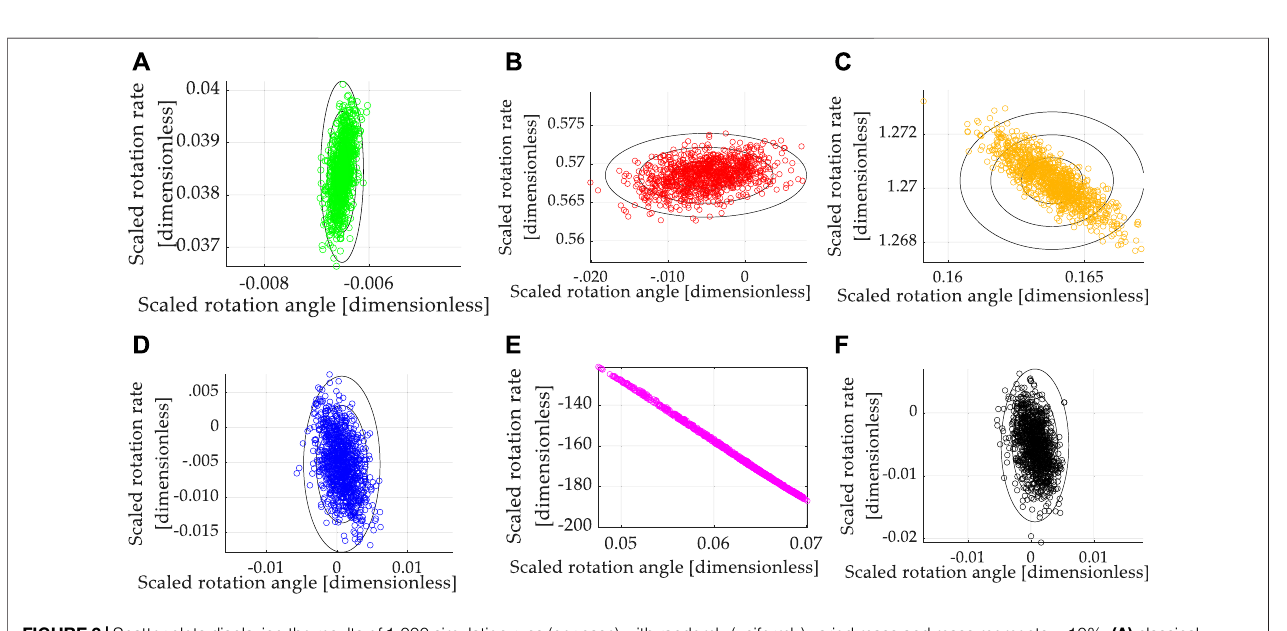
Frontiers in Robotics and AI |